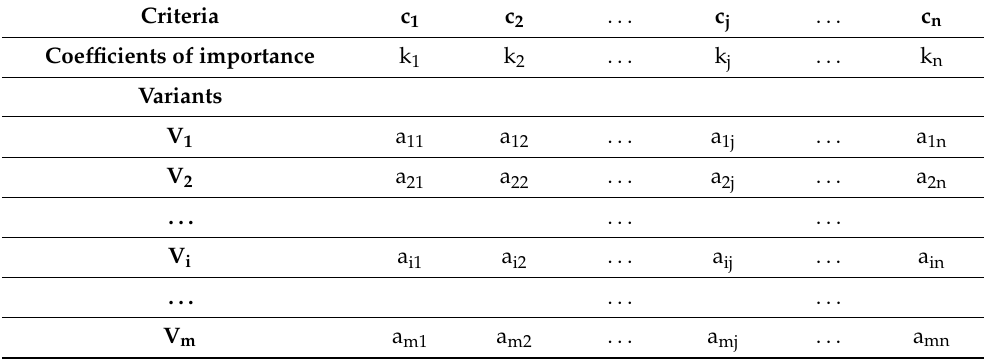
Table 2. Matrix of values. Criteria c 1 c 2 . . . c j . . . c n Coefficients of importance k 1 k 2 . . . k j . . . k n Variants V 1 a 11 a 12 . . . a 1j . . . a 1n V 2 a 21 a 22 . . . a 2j . . . a 2n . . . . . . . . . V i a i1 a i2 . . . a ij . . . a in . . . . . . . . . V m a m1 a m2 . . . a mj . . . a